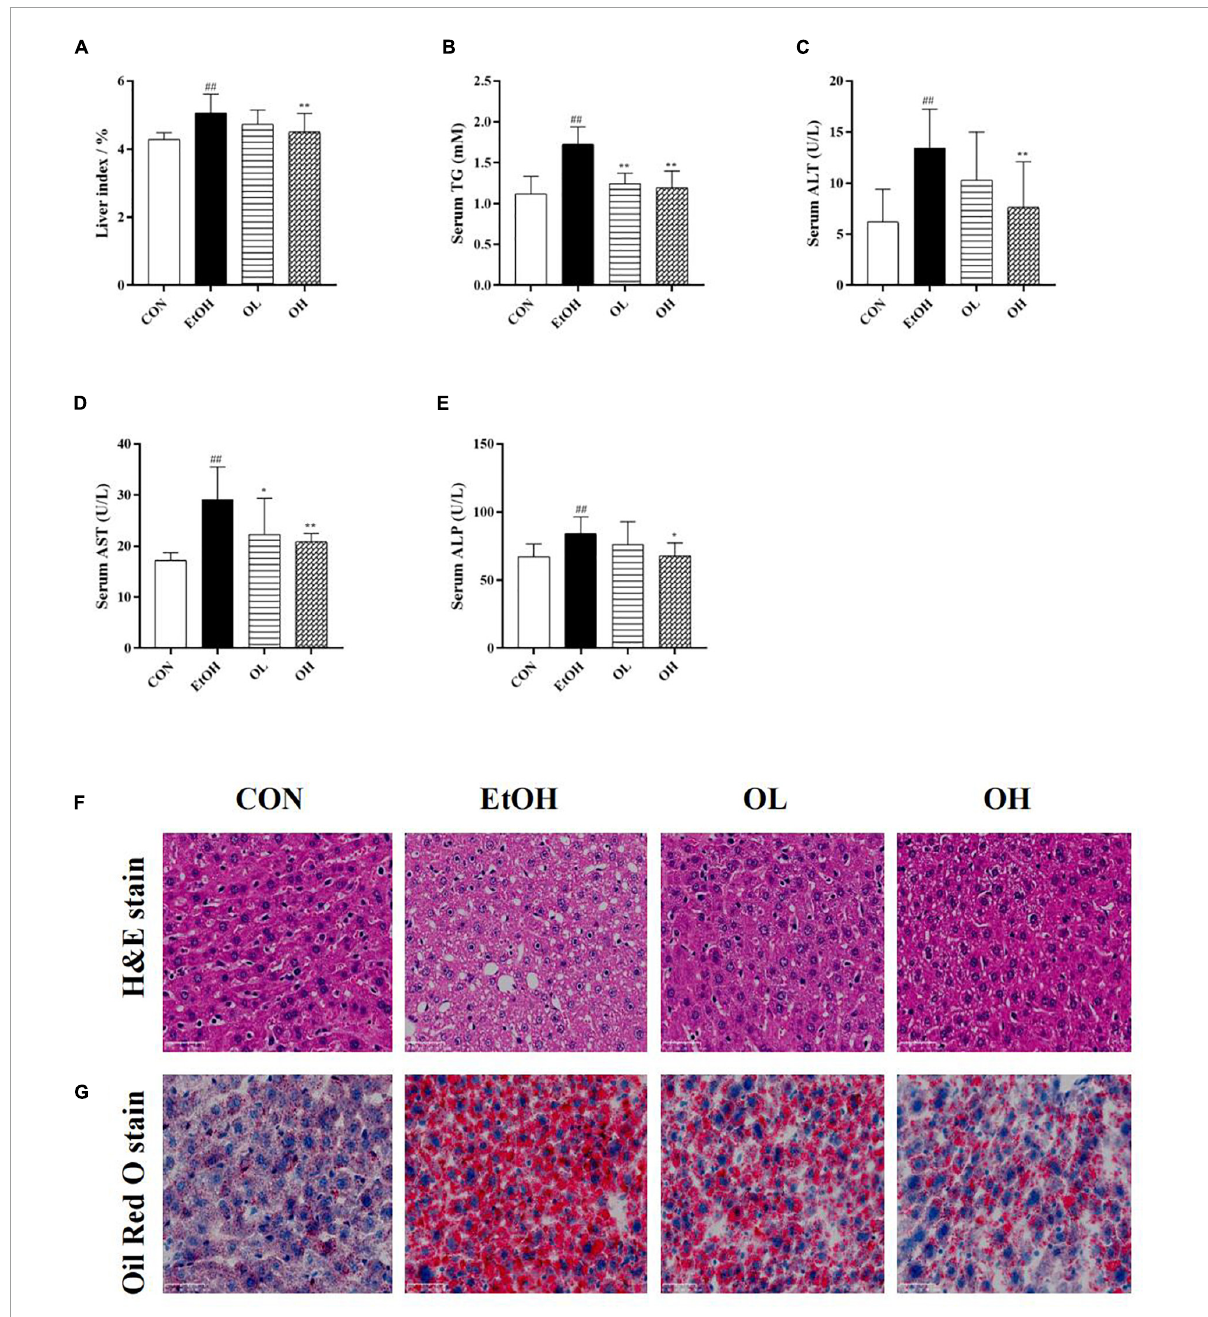
FIGURE3 Effect of OEB treatment on hepatic basic indices and histopathological alterations of ALD mice basic indices of the mice. (A) Effect of OEB on liver index of mice. (B) Effect of OEB on hepatic triglyceride levels. (C,D) Effect of OEB on serum transaminase content. (E) Effect of OEB on serum ALP levels. (F) H&E staining and (G) Oil red O staining of liver tissue sections (scale bar, 50 µ m). CON, control group; EtOH, ethanol administration group; OL, low-dose OEB group; and OH, high-dose OEB group. Data are presented as “mean ± SD”. N = 8, for all groups. ## EtOH versus CON, P < 0.01; * OL or OH versus EtOH, P < 0.05; ** OL or OH versus EtOH, P <